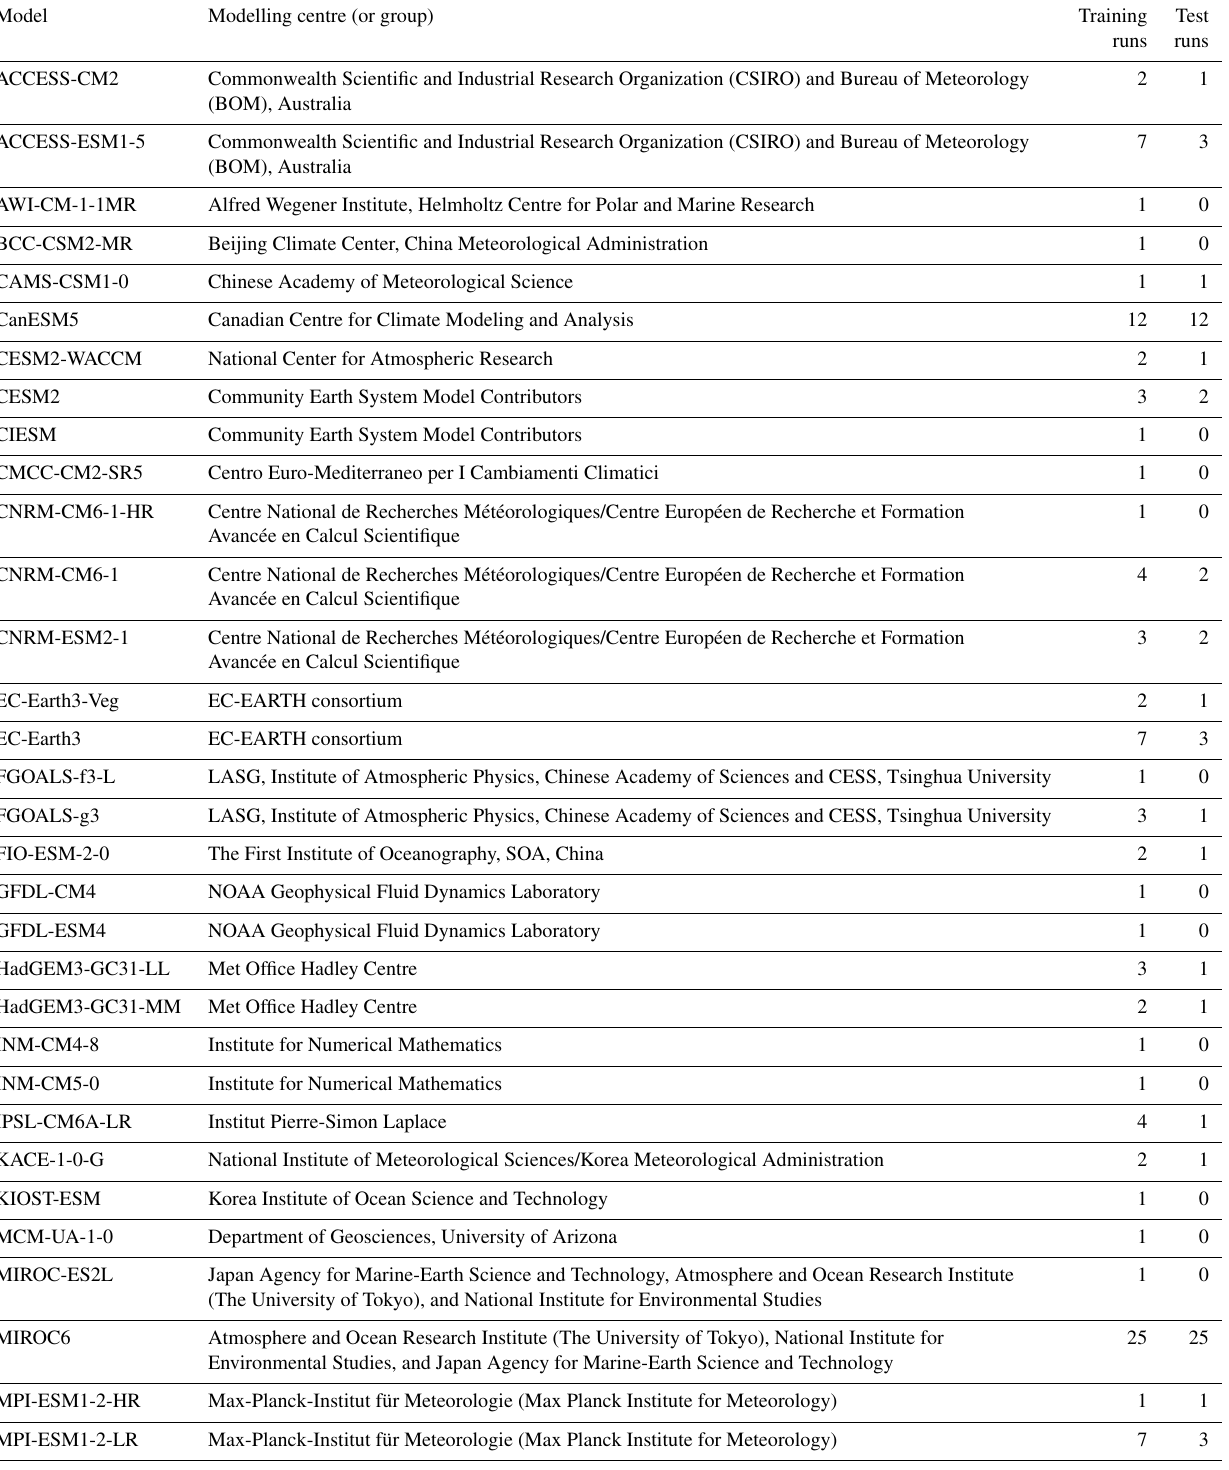
Table A1. List of the 38 employed CMIP6 models, the modelling groups providing them, and the number of initial-condition ensemble members used in the training and test